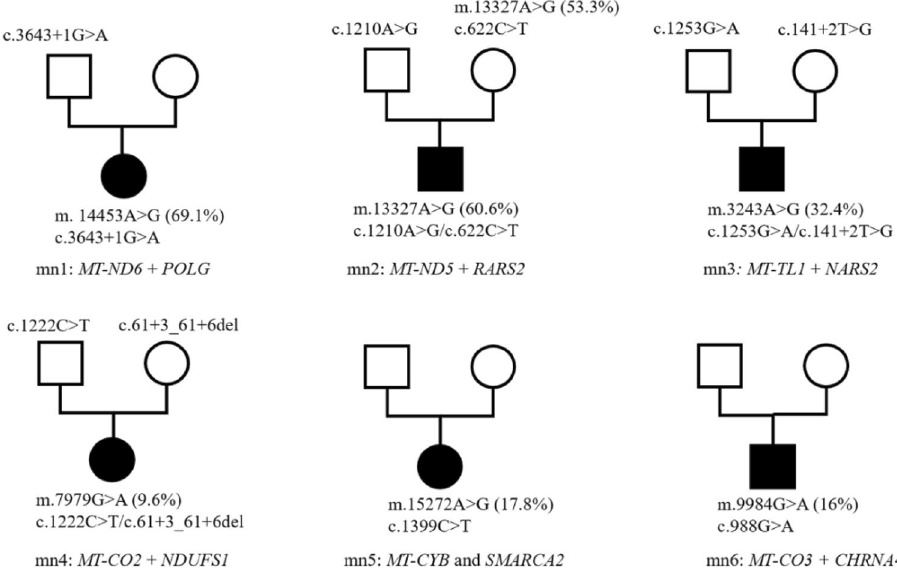
Figure 1. Family pedigree of six patients with dual genomic variants.